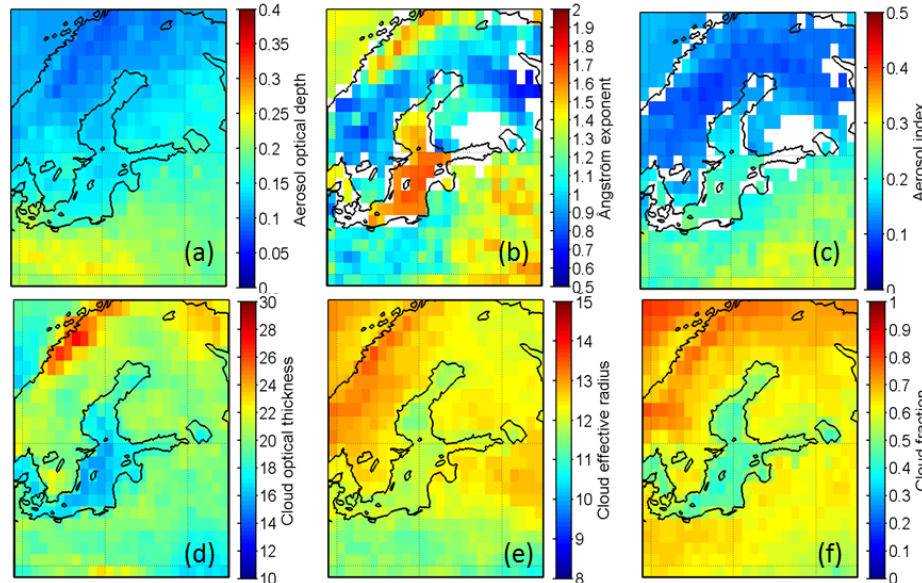
Figure 3. Spatial distributions of AOD (a) , AE (b) , AI (c) , COT (d) , CER (e) and CF (f) averages for summer seasons between 2003 and